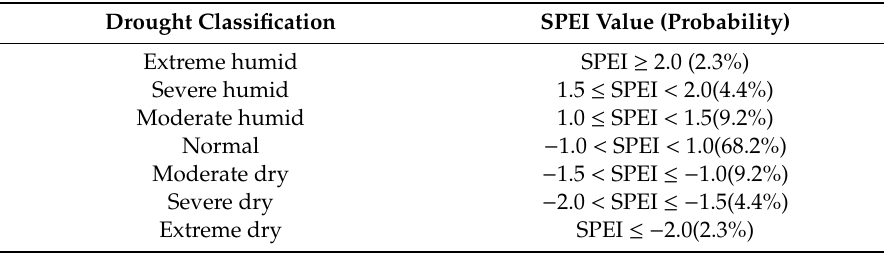
Table 2. The standardized precipitation–evapotranspiration index (SPEI) categories based on the initial classification of SPEI